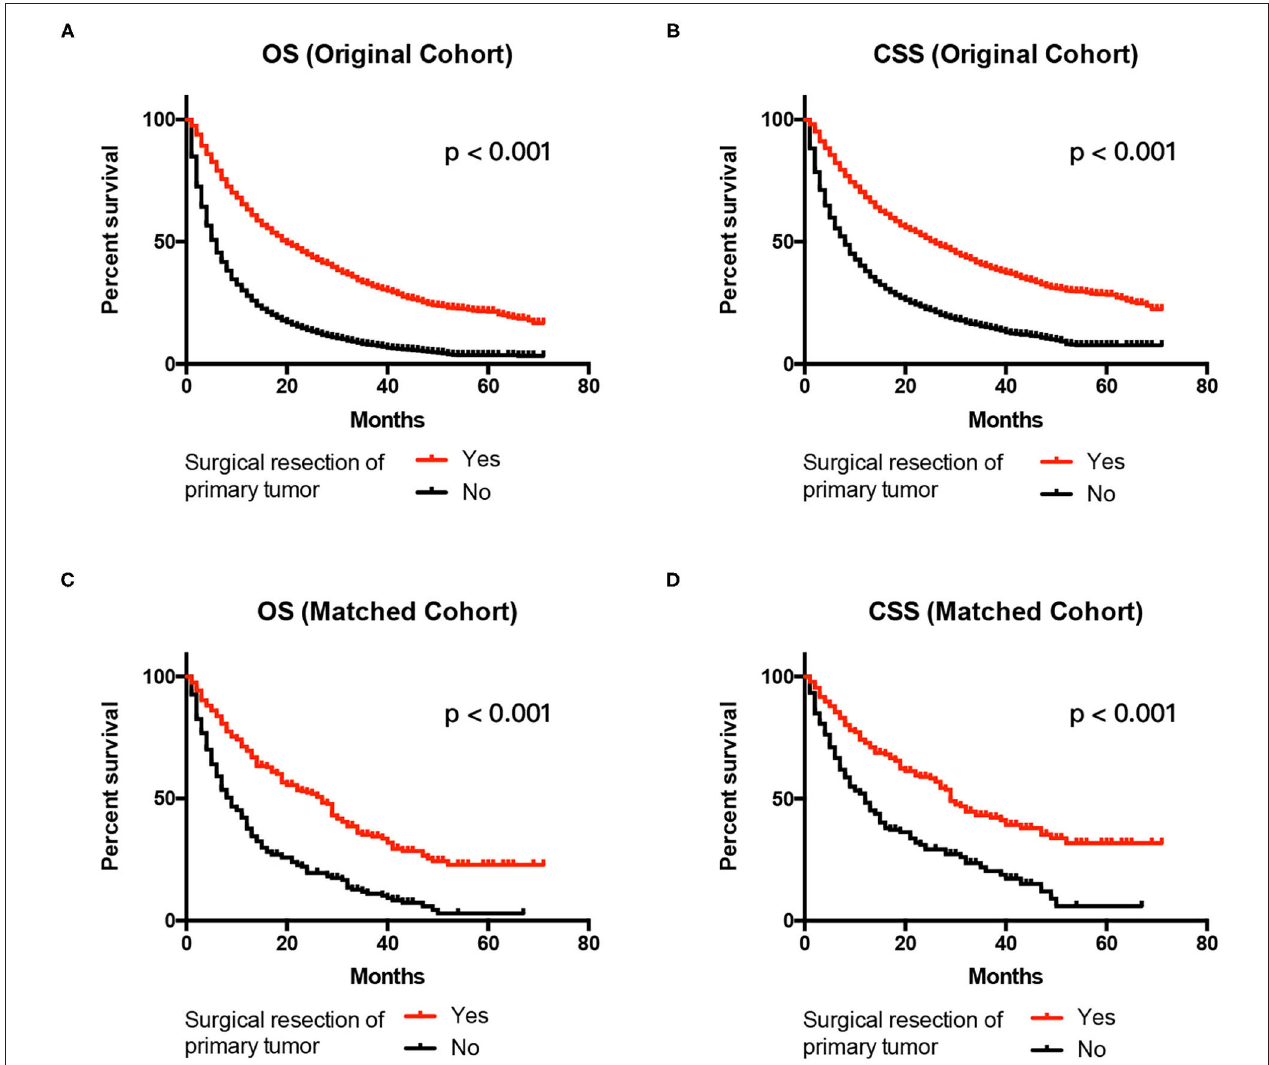
FIGURE 3 | Kaplan–Meier Curves and log-rank test for the survival analysis. Comparing OS between the surgery and no surgery groups in the original cohort (A) and the matched cohort (C) . CSS was examined in the original cohort (B) and the matched cohort (D) . CSS, cancer-specific survival; OS, overall